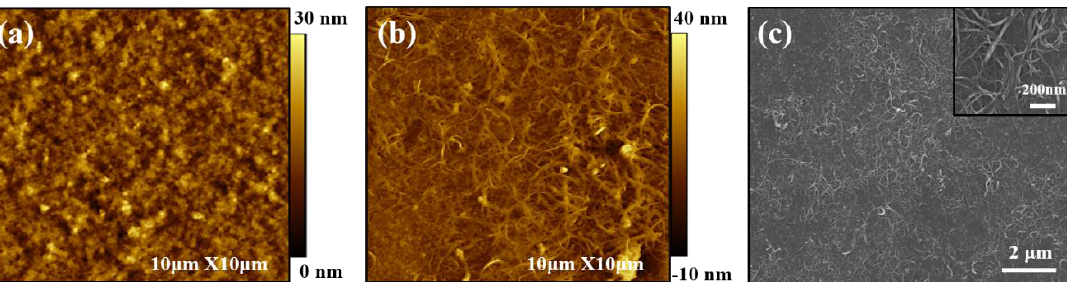
Figure 7. AFM height images of ( a ) PANi/PEDOT:PSS and ( b ) PANi/SWNT-PEDOT:PSS, and ( c ) SEM micrograph of 20 BL PANi/SWNT-PEDOT:PSS thin films deposited on glass slides via spray-ing method. The inset in the SEM image shows higher resolution of the SWNT network.